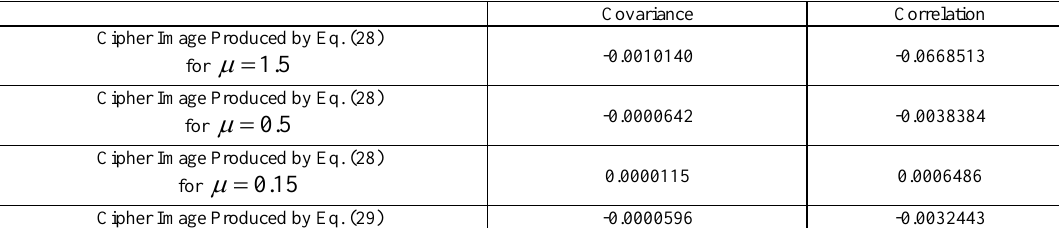
Table 2 . Covariances and correlations of the non-fractal image (Figure 1 on the right side) data based on the weighted data (gradient orientation filter, gradient filter) images. Covariance Correlation Cipher Image Produced by Eq. (28)